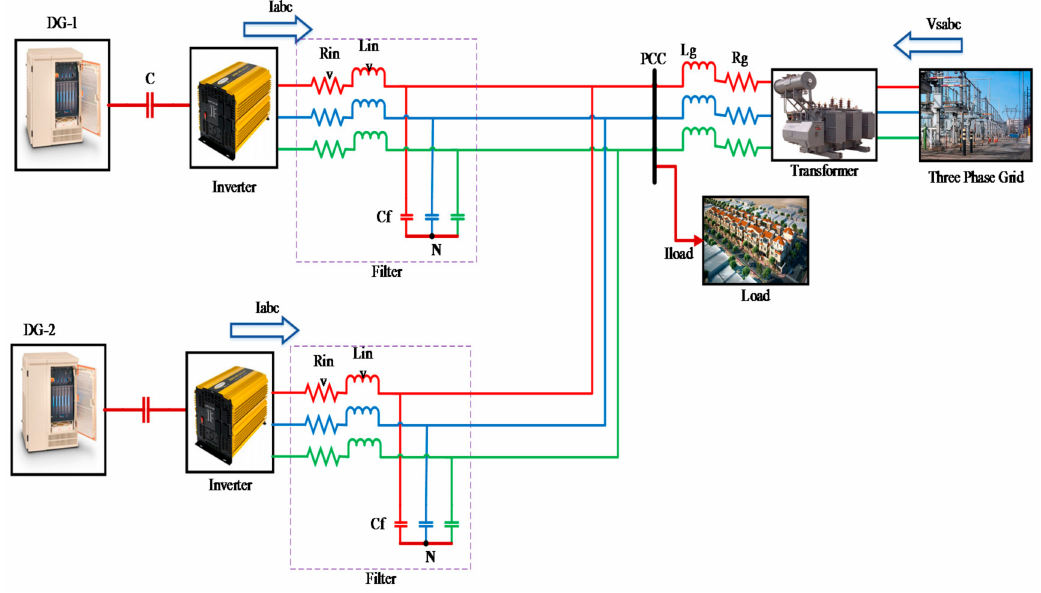
Figure 2. Three Phase Grid connected with DG